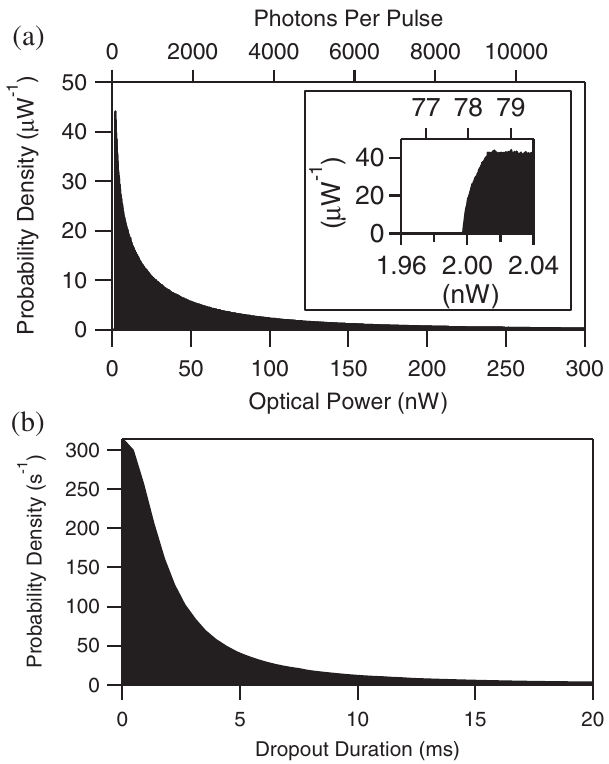
FIG. 6. Turbulence-induced power fluctuations and dropouts. (a) Probability density of received optical comb power for the 50 h of data shown in Fig. 4. Inset shows the ∼ 2 -nW threshold. (b) Probability density of dropouts versus duration. 90% of the dropouts are below 10 ms. Longer durations are typically due to a disruption of the beam from physical objects, realignment, or heavy precipitation, rather than turbulence. The typical turbu- lence structure function is C 2 n ≈ 10 − 14 m − 2 = 3 over the